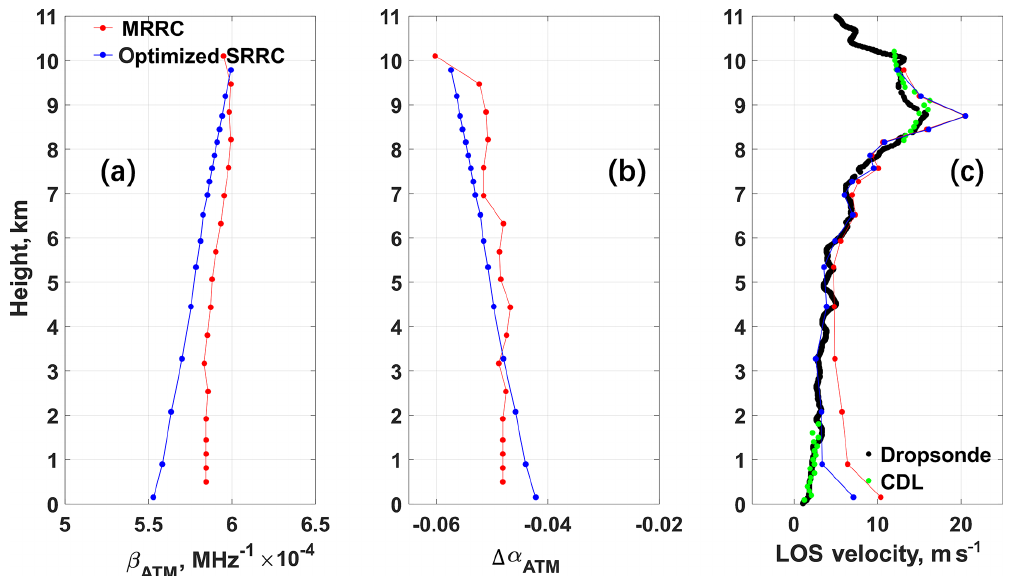
Figure 9. Case study using dropsonde data on 08:27:07UTC, 23 September 2016: comparison of (a) sensitivity β ATM (MHz − 1 ), (b) (cid:49)α ATM , and (c) retrieved LOS velocity between results from A2D Rayleigh channel MRRC (red) and optimized SRRC (blue). The LOS velocity data from dropsonde (black) and CDL (green) are also presented in Fig.